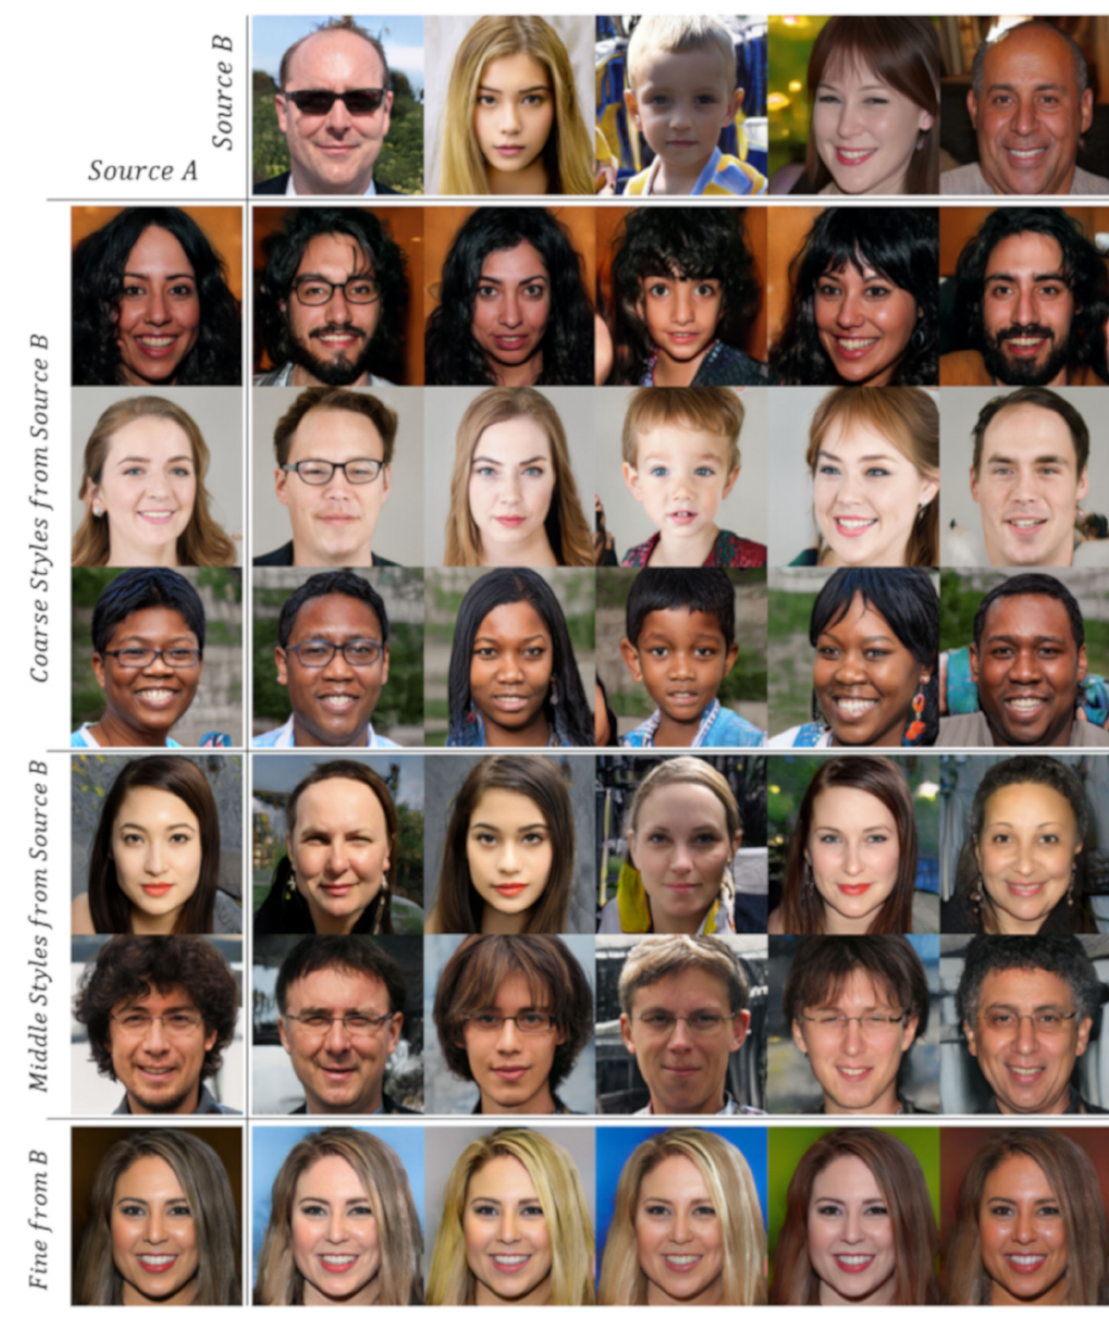
Figure 17. Result of style synthesis in two generated images